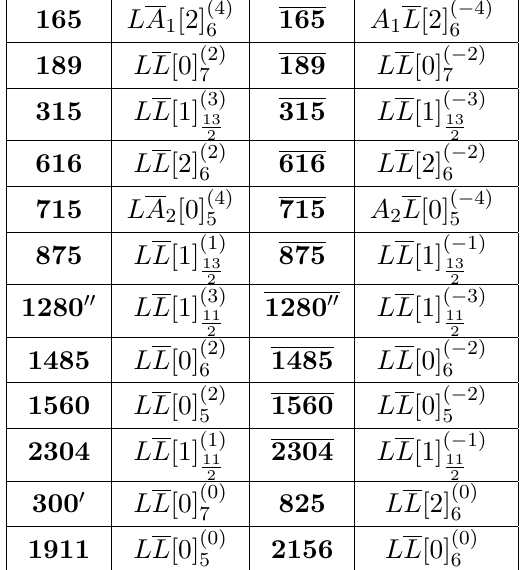
Table 14 . The N = 2 multiplets from level n = 8